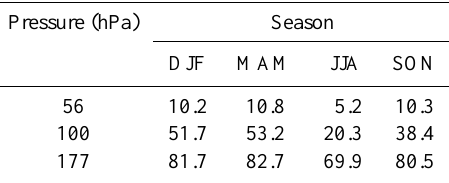
Table 1. Relative number (%) of days in southern tropical Amer- ica for which the |D-N| is greater than 10% with respect to all the days when both an average daytime and night-time were available (1639 days) between 2005 and 2012. Pressure (hPa) Season DJF MAM